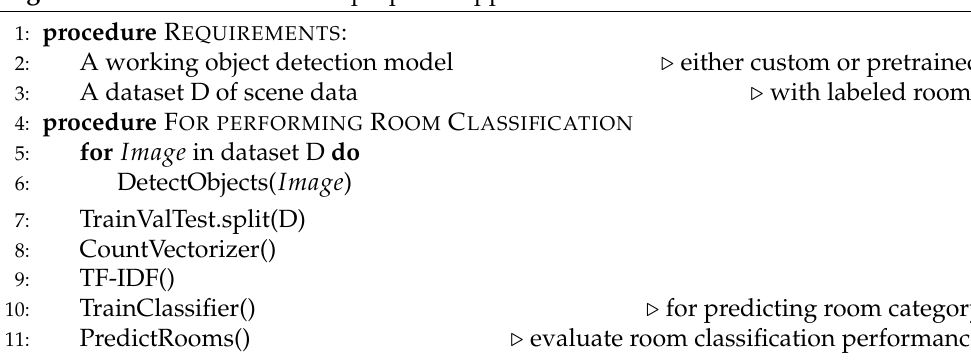
Algorithm 1 Pseudocode of the proposed